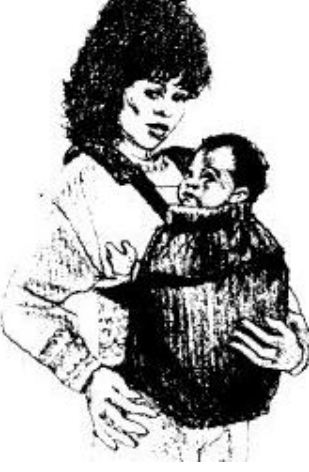
Figure 37. A Front Pack was Recommended as a Handy Alternative to a Stroller.